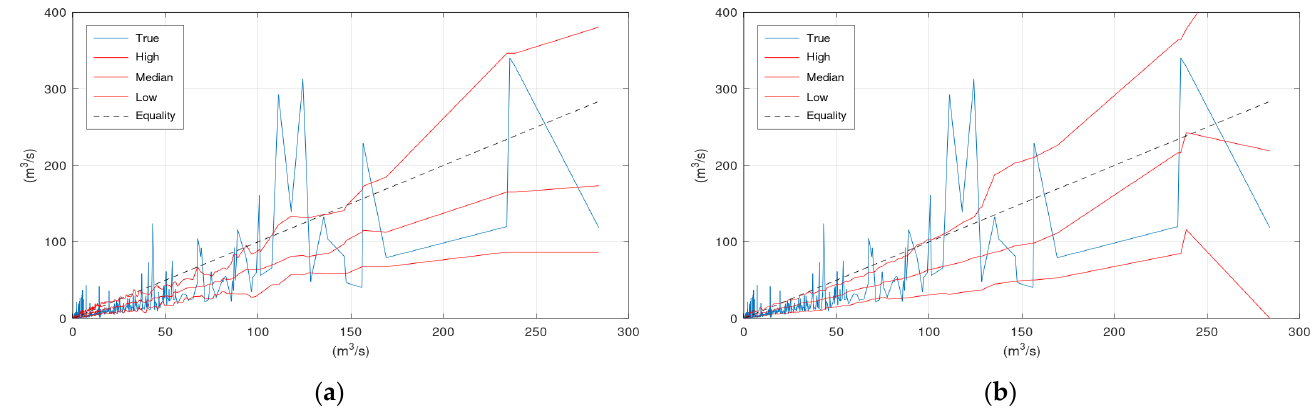
Figure 3. Scatter plot of the Arno River case study: ( a ) KNN; ( b )